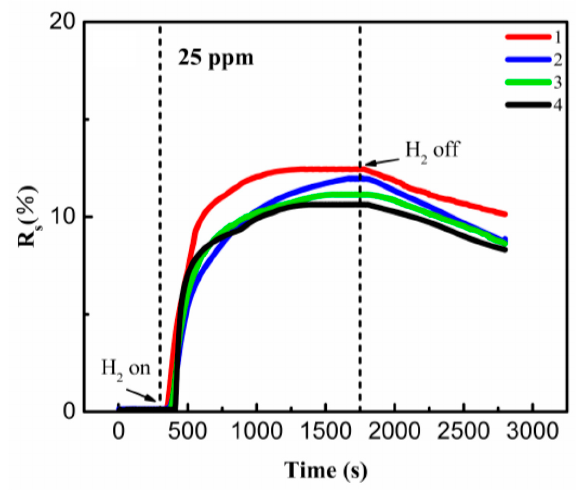
Figure 9. The response of the sensor under 25 ppm H 2 in